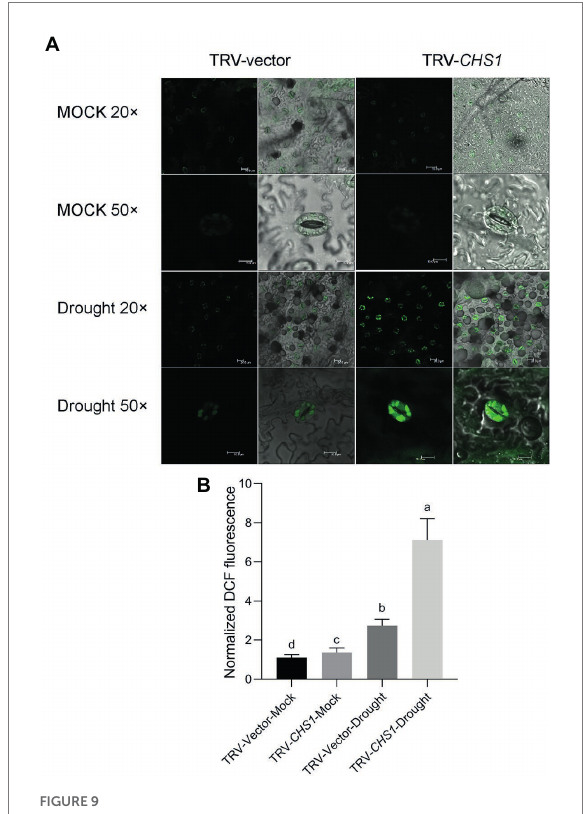
FIGURE 9 SlCHS1 -silenced plants exhibited more ROS accumulation in guard cells under drought stress. (A) Confocal micrographs of H 2 DCF-DA-stained guard cells of TRV-Vector and TRV- CHS1 plants subjected to drought and mock treatments. DCF fluorescence is shown in green (bar = 20 μ m). (B) Quantification of DCF fluorescence in guard cells (TRV-vector-MOCK: n = 498; TRV- CHS1 -MOCK: n = 500; TRV-vector-Drought: n = 498; TRV- CHS1 -Drought: n = 494). Data were obtained from three experiments. Different letters represent significant differences ( p < 0.0001), as determined using Tukey’s multiple comparisons